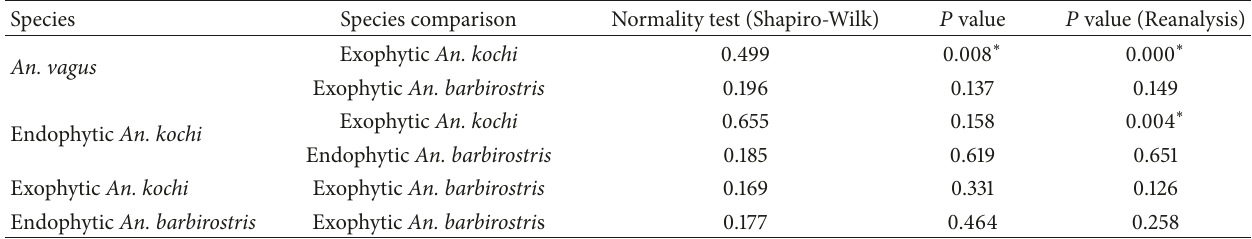
Table 5: Comparison of MBPH between An. vagus, An. kochi , and An. barbirostris